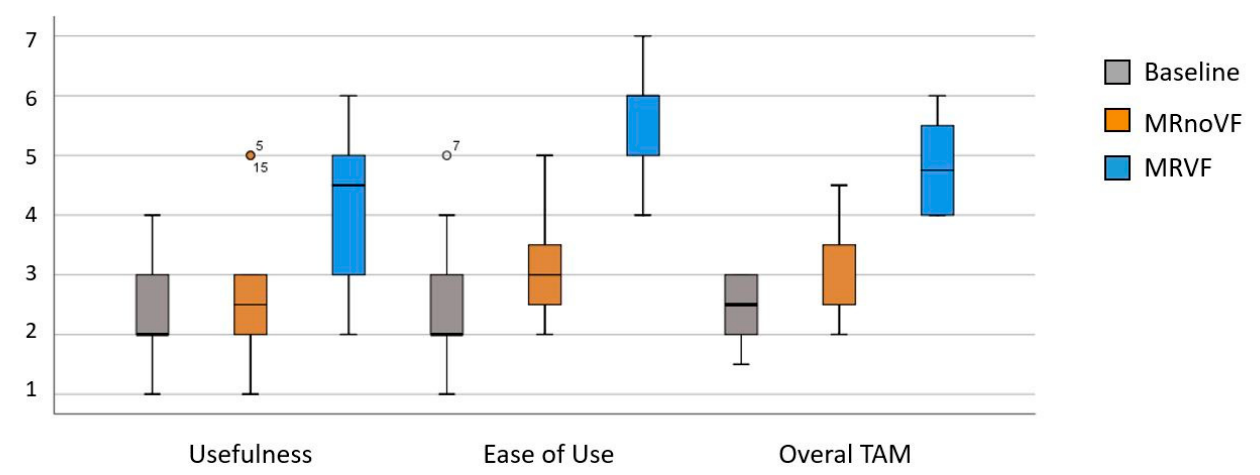
Figure 12. Subjective scores on system functionality, usability, and user’s acceptance and perception of the three tele- welding modules. Higher scores represent higher preferences in all cases. The MRVF design demonstrated improvements in perceived usefulness and perceived ease of use. The special symbols (circles) are outliers in the data, representing that they are outside of a certain range indicated by the boxes in the box plot. The numbers next to the circles indicate which observations in the dataset are outliers.